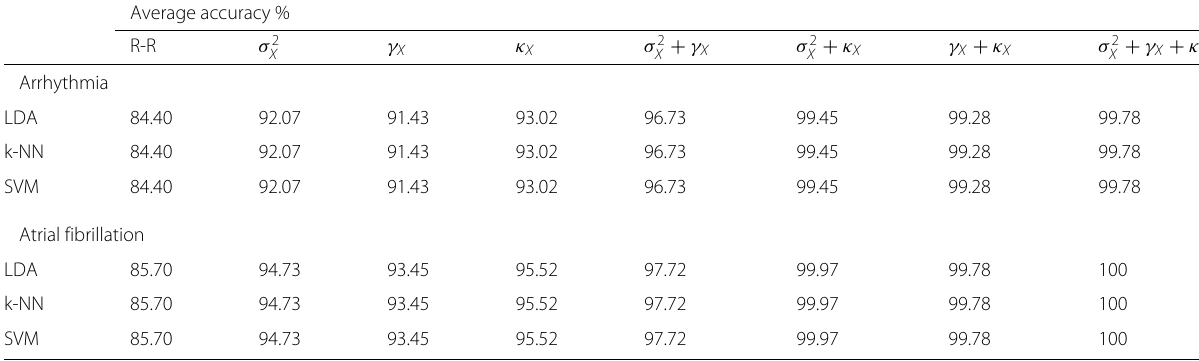
Table 3 Average accuracy of the classifiers (LDA, k-NN, SVM) using the proposed data